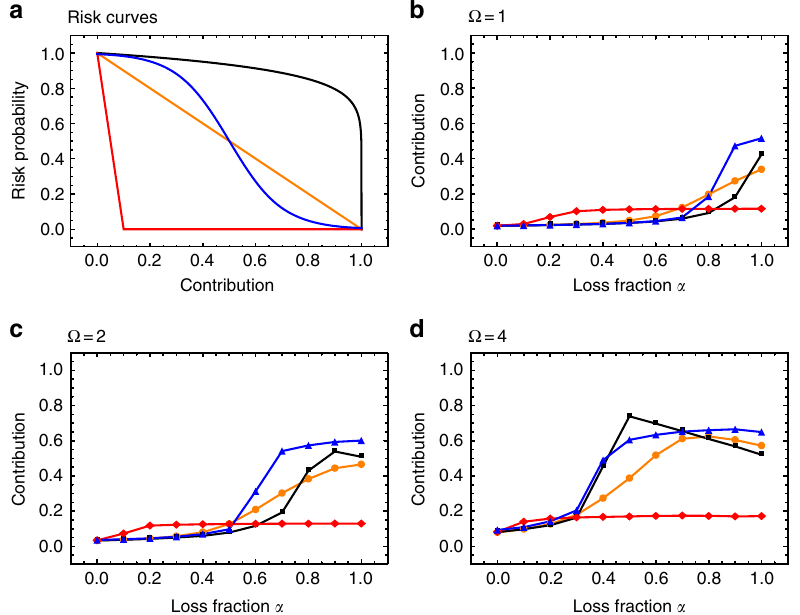
Fig. 1 Risk curves and the effect of the fraction lost on contributions. a Four different risk curves are explored: linear (orange), piece-wise linear (red), a power function (black), and curves exhibiting threshold effects (blue). In the remaining panels, the average contributions for different values of the fraction lost, α , are shown. b In the collective-risk game with one round ( Ω = 1) exclusively large values of α elicit contributions. c In the game played over two rounds contributions tend to rise in α . d Multiple potential losses induce a clear rise in contributions (games are between two individuals, m = 2, evolutionary dynamics with a population size N = 100 and averages over 10 5 generations, 1000 games per generation, mutation probability μ = 0.03, and the standard deviation for mutations in the individual thresholds determining contributions τ r is set to σ = 0.15 (Methods section). The functional forms of the curves are given in the Methods